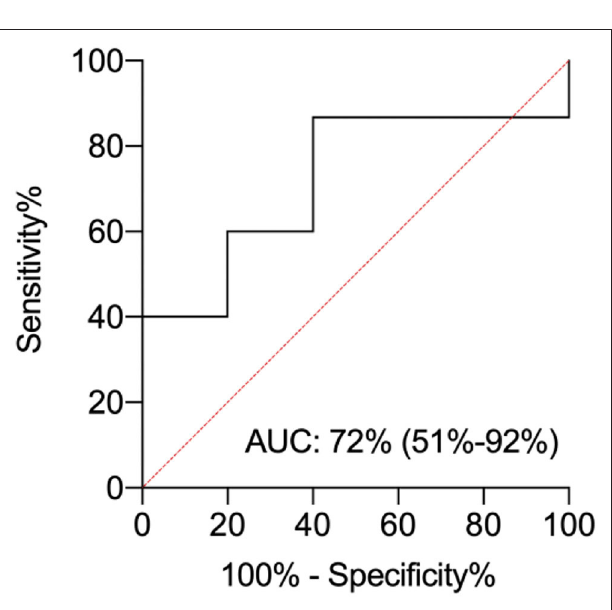
FIGURE 2 | ROC curve analysis for plasma isoprostanes (pl-IPs) concentration between 24 and 48h after birth. The area under the curve is 0.72 (C.I. 95% = 0.51–0.92). The pl-IPs levels plotted curve indicated 31.8 pg/ml as the best predictive threshold with a sensitivity of 86% and a specificity of 60%. ROC curve discriminates newborns with any WMI from newborns without